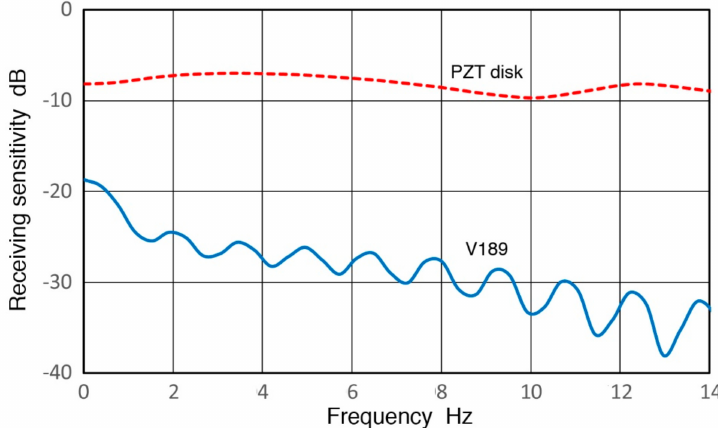
Figure 28. Receiving sensitivities of V189 (blue) and PZT disk (red dash) vs.